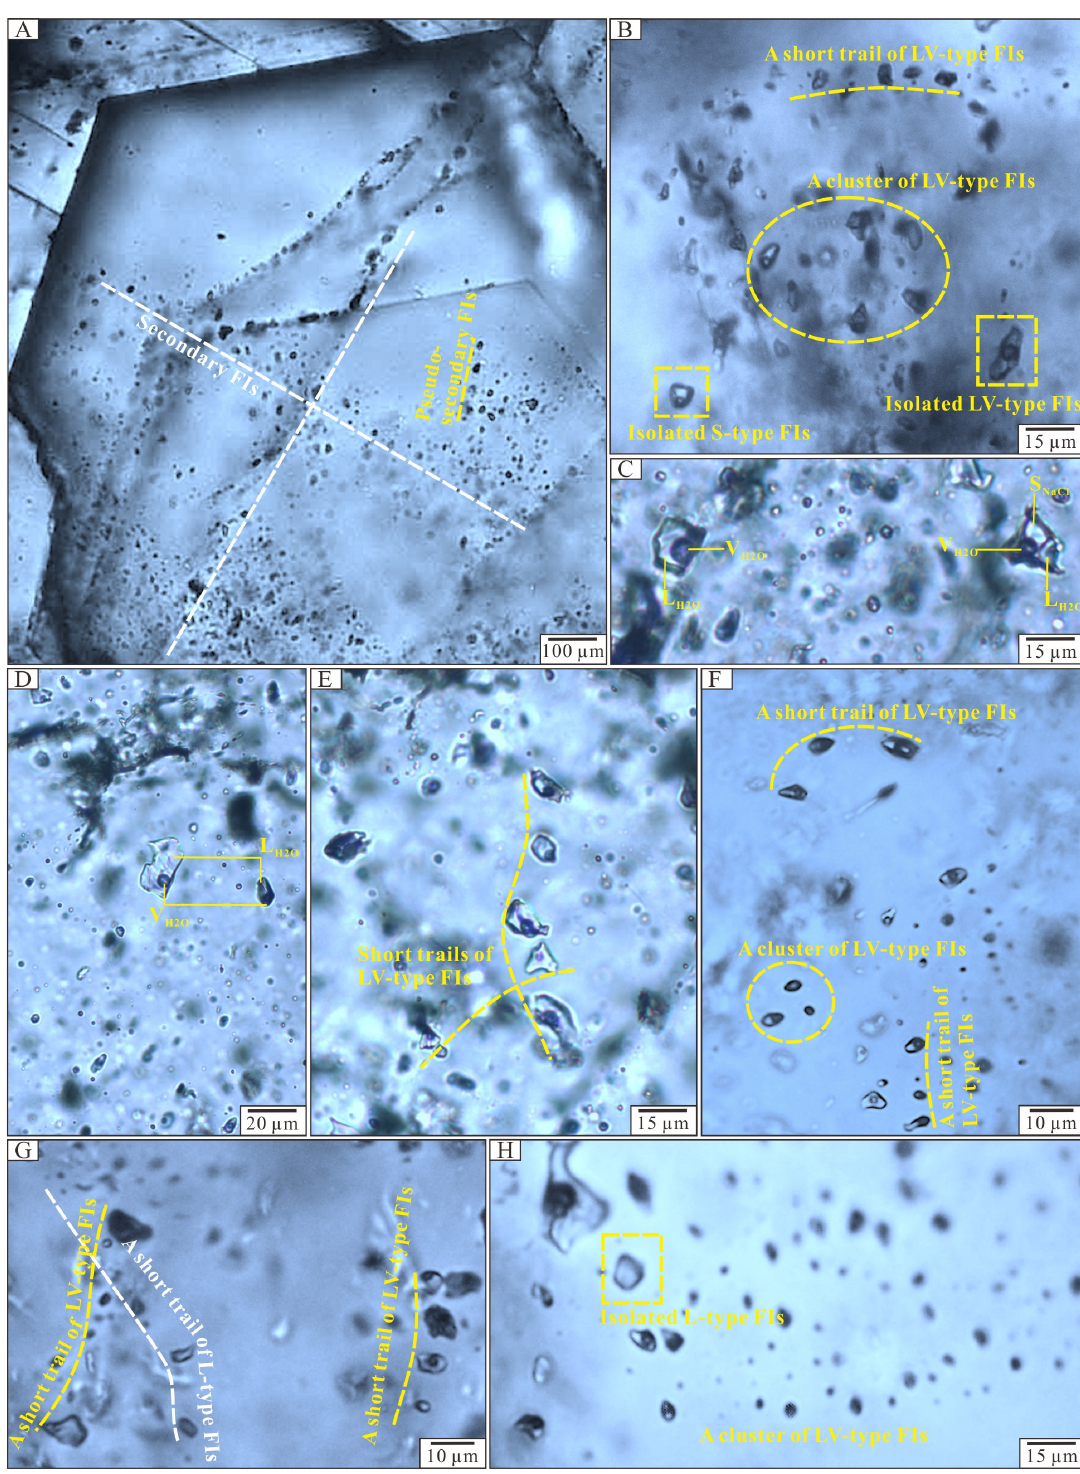
Figure 5. Photographs showing FIs in quartz from early to late stages of the Harla gold deposit. ( A ) pseudo-secondary FIs and secondary FIs in quartz crystals; ( B ) isolated S-type FI and short trails of LV-type FIs in early stage quartz; ( C ) isolated S- and LV-type FI in early stage quartz; ( D ) neighboring LV-type FIs in a microdomain in intermediate stage quartz ( E ) crosscutting short trails of LV-type FIs in intermediate stage quartz; ( F ) a cluster and two short trails of LV-type FIs in intermediate stage quartz; ( G ) a trail of L-type FIs crosscutting a short trail of LV-type FIs in late stage quartz; ( H ) isolated L-type FI and a cluster of LV-type FIs in late stage quartz. Abbreviations: S—daughter mineral; L—liquid phase; V—vapor phase.